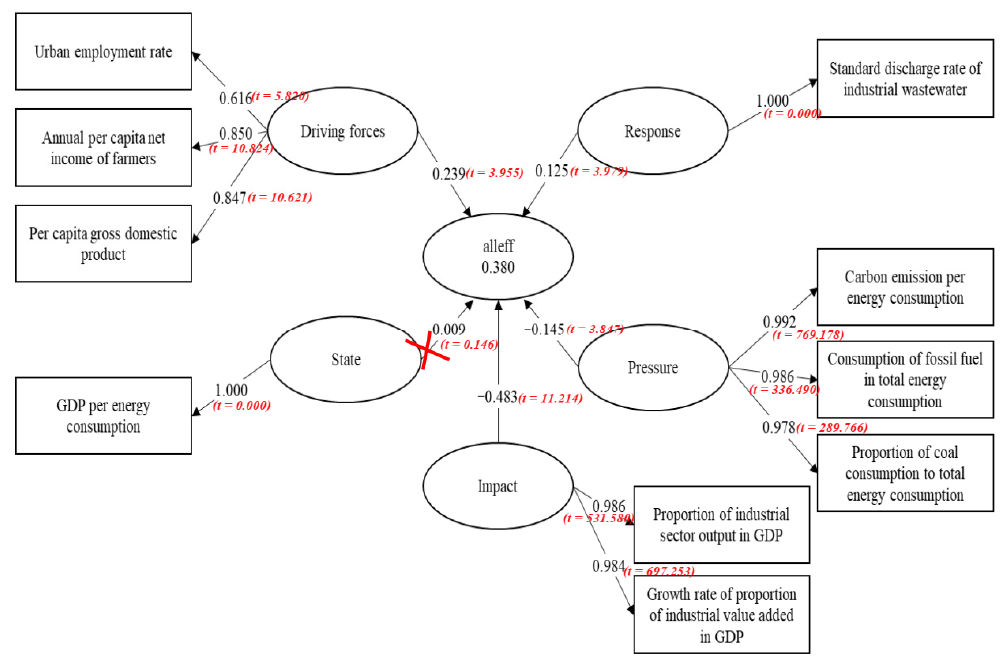
Figure 11. Influencing factors of efficiency in the overall stage based on DPSIR and PLS-SEM. (Source: Authors compiled).